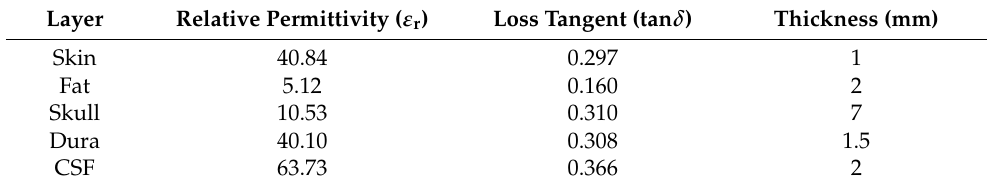
Figure 2. The proposed Vivaldi antenna surrounded by insulators and embedded in the skull. Table 1. Material properties of brain tissues at 4 Table 1. Material properties of brain tissues at 4 GHz.